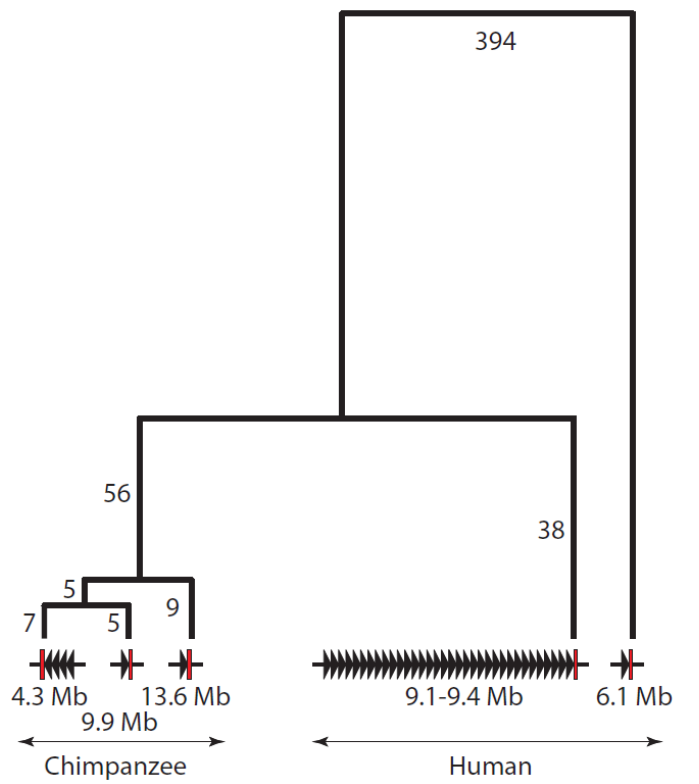
Figure 2. Phylogenetic relationships of the two human and three chimpanzee TSPY arrays deduced from comparisons of the flanking sequences circled in Figure 1 (coordinates in text). The arrays, named according to their approximate genomic coordinates, are shown at the bottom, with active TSPY genes indicated by black arrowheads and the flanking region by a red rectangle. The topology of the tree is shown and the number of mutational events on each branch indicated, but the branches are not drawn to scale. Note that no outgroup sequence is available and the tree is